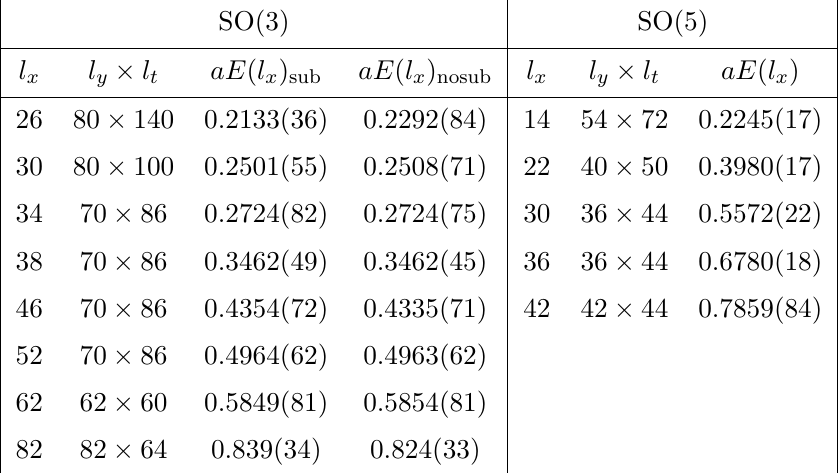
Table 7 . Energy of the ground state (cid:13)ux tube versus its length, in SO(3) at (cid:12) = 9 : 0, both vacuum subtracted and unsubtracted, and in SO(5) at (cid:12) = 27 : 5. SO(5)